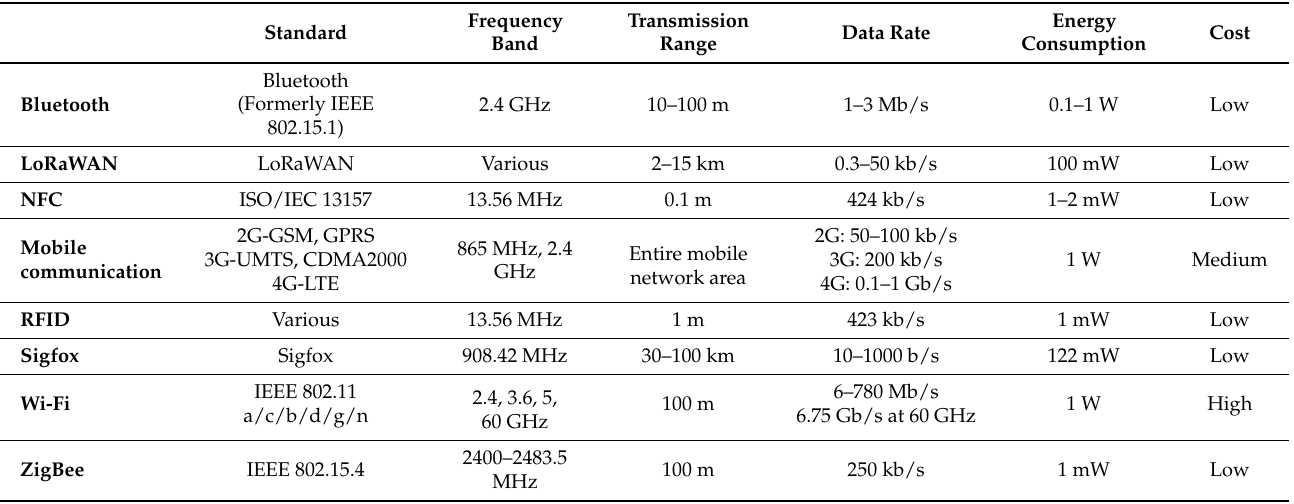
Table 4. Summary of most common wireless communication protocols and basic characteristics. Adapted from